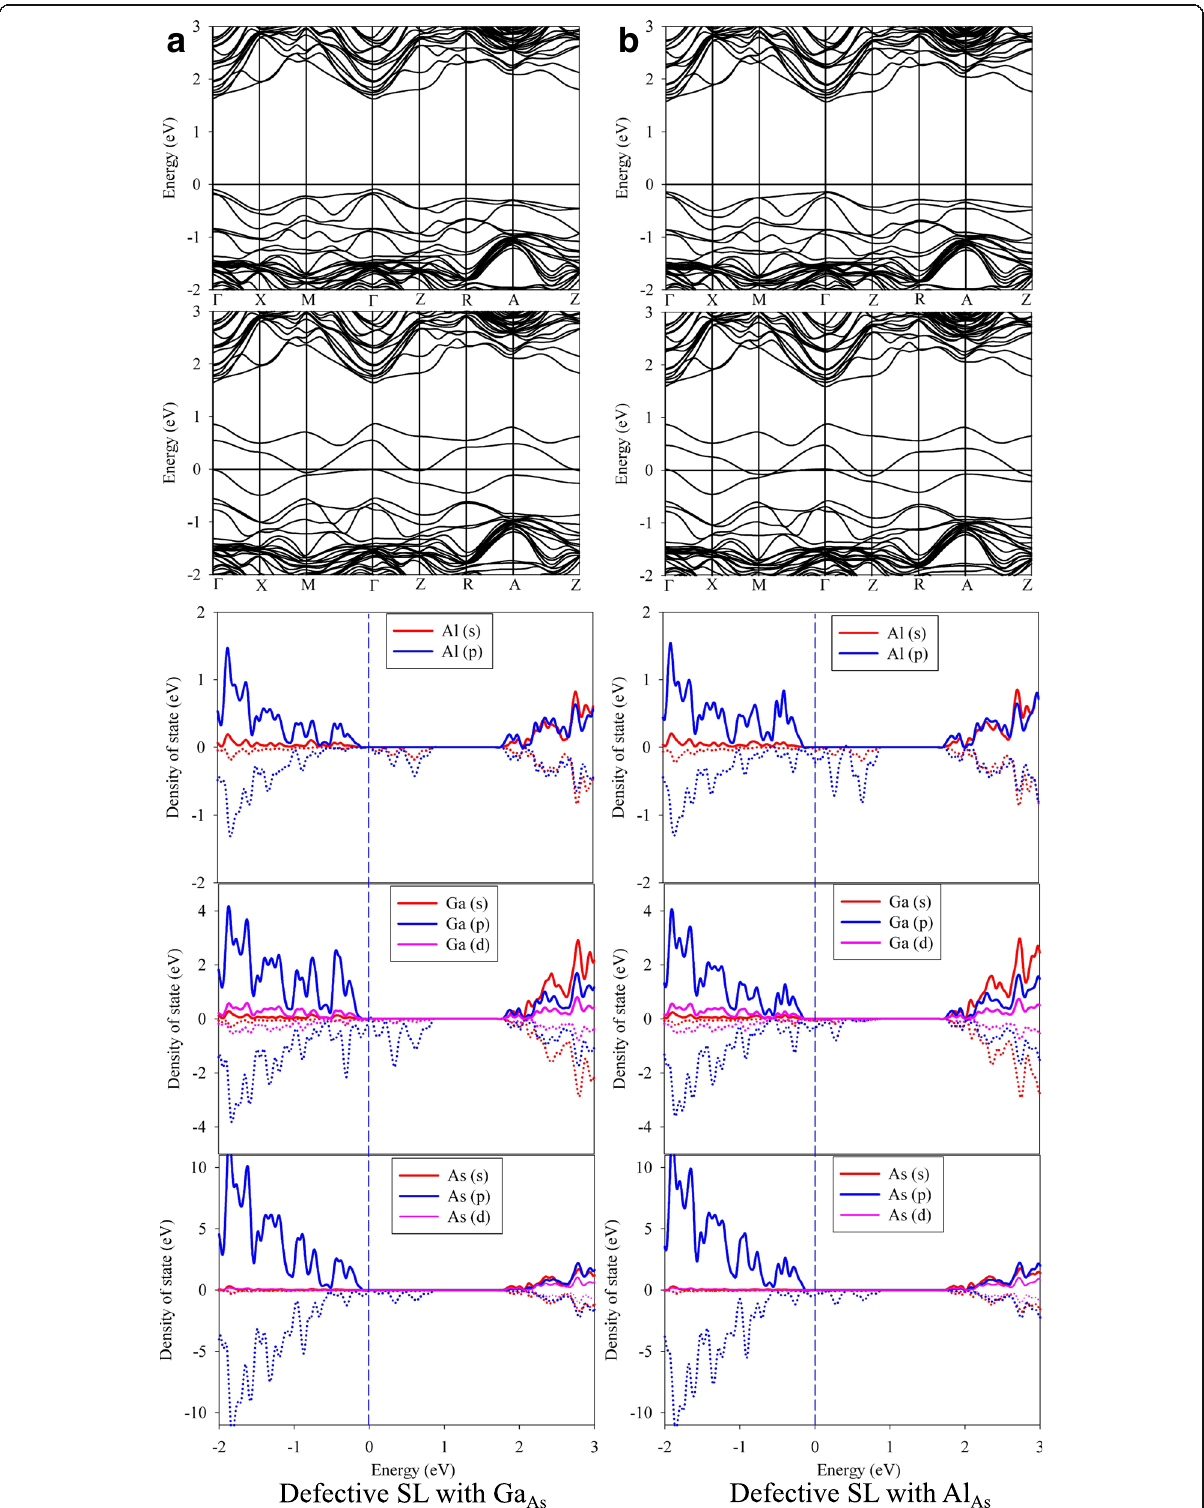
Fig. 6 The band structures and partial density of state of defective GaAs/AlAs superlattice with a Ga As and b Al As antisite defects. X As (X = Ga or Al) X occupying the As lattice